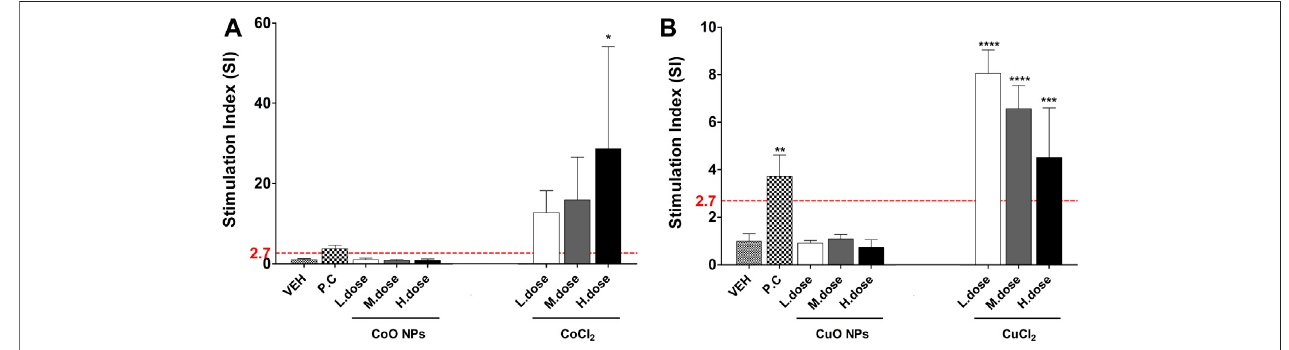
FIGURE 7 | The SI value in LLNA-FCM assay due to metal oxide NPs and component metal ions (Cobalt and copper). Animals were treated with: (A) Cobalt- containing compound, and (B) Copper-containing compound. Data are expressed as mean ± standard deviation values (n (cid:2) 4). Signi fi cance vs. vehicle control: **** p <